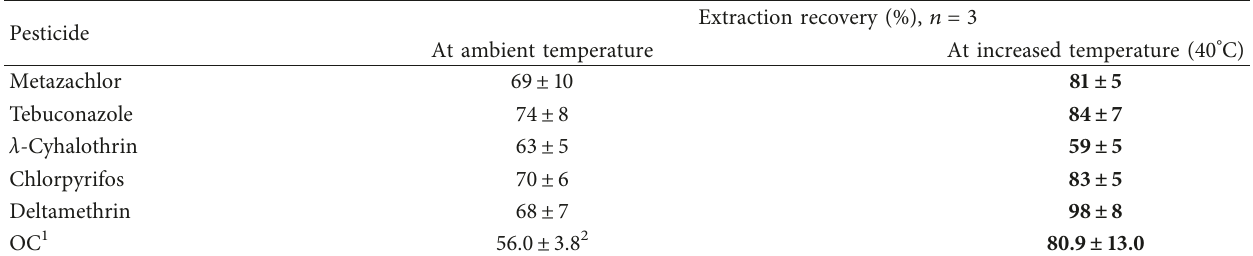
Table 6: Effect of the desorption temperature on extraction efficacy of the five pesticides from rape oil samples.